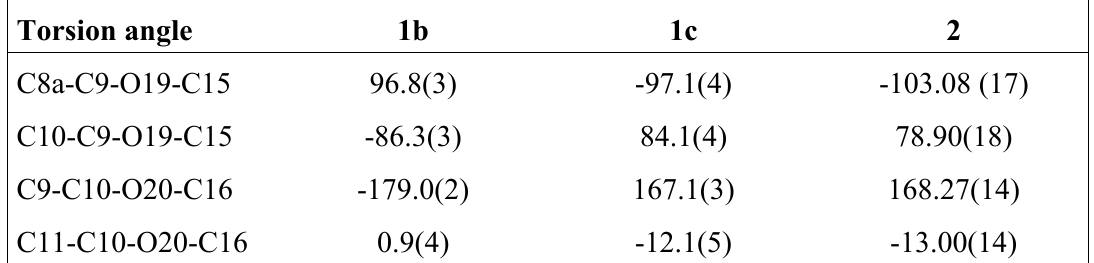
Table 4 . Selected torsion angles in compounds 1b , 1c , and 2